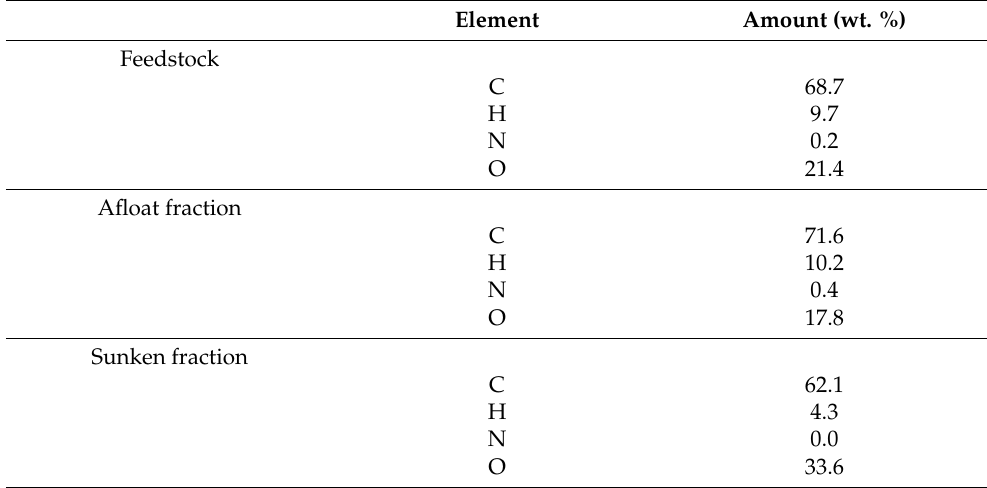
Table 1. Elemental analysis on dry basis of the feedstock and of the two fractions obtained by density separation (afloat and sunken).